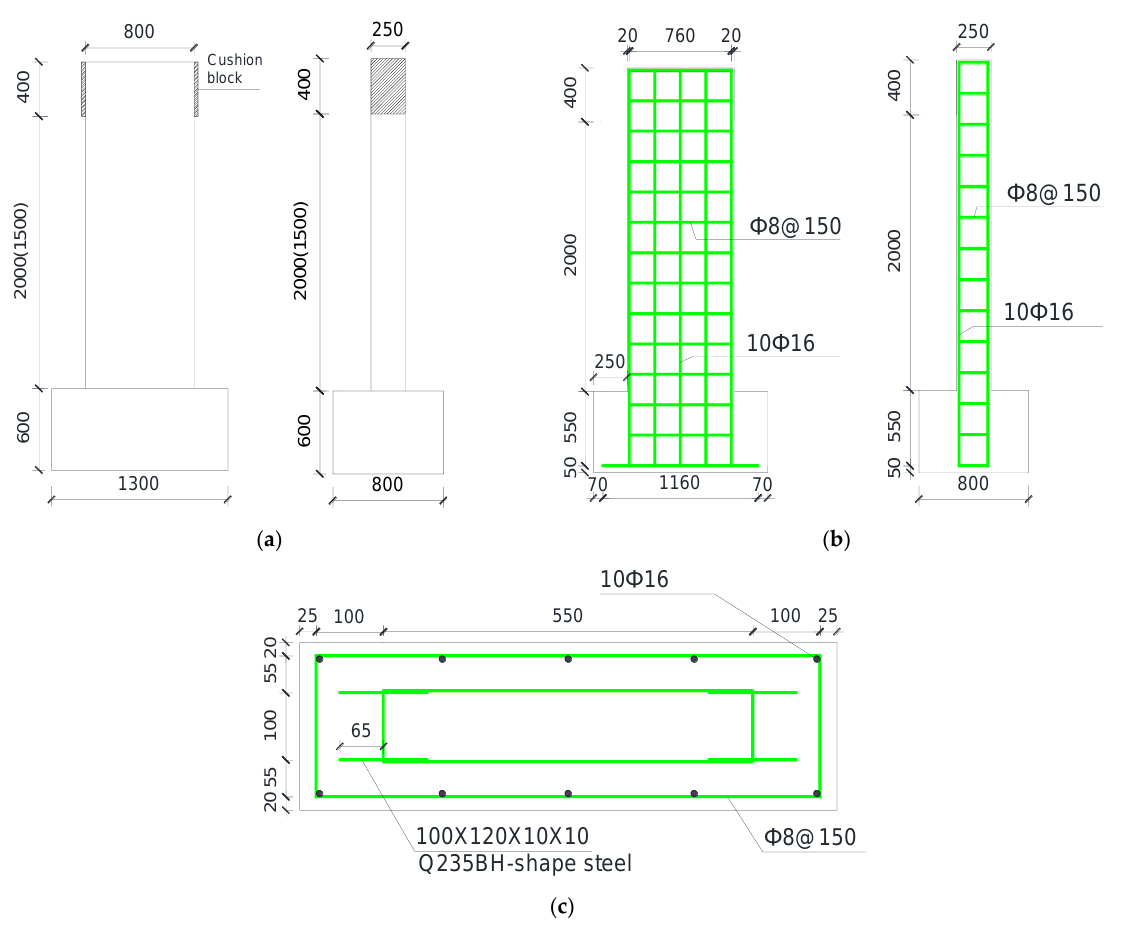
Figure 1. The Dimension and Steel Arrangement of the Test Specimens. ( a ) The dimensions of the test specimens. ( b ) Reinforcement arrangement. ( c ) H-shape steel arrangement. Based on the above-mentioned design parameters and drawings, the three specimens were manufactured in the laboratory; the reinforcement skeleton was constructed based on the longitudinal and hooped reinforcements. Then, the batten plate was welded on the wing of the adjacent H-shape steel. Afterward, the reinforcement skeleton and H-shape steel were assembled for the subsequent pouring of concrete. The process is illustrated in Figure 2.